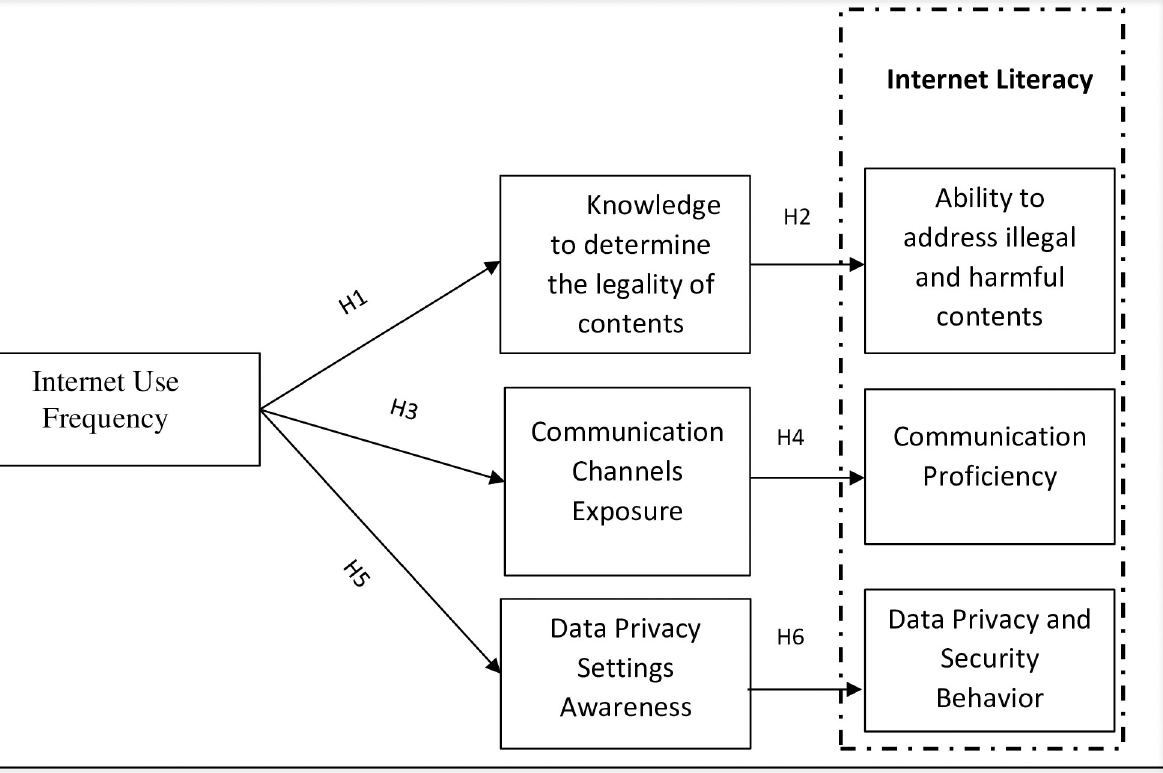
Fig 1. Proposed hypothetical